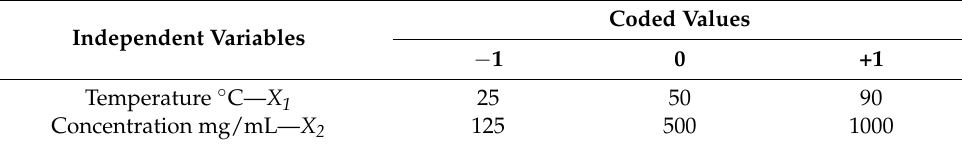
Table 2. Actual and coded values of experimental design.